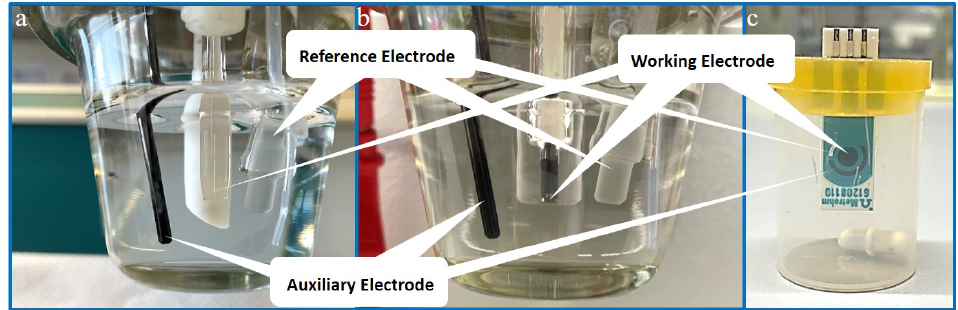
Figure 2. Photographs of the used voltammetric measurement cells: ( a ) HMDE setup, ( b ) solid state eletrode setup for BiFE measurement, ( c ) measuring cell with screen-printed electrode for BiSPE measurement.